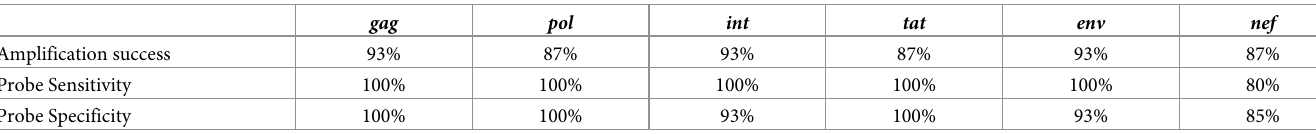
Table 2. MHA B/non-B participant reference panel